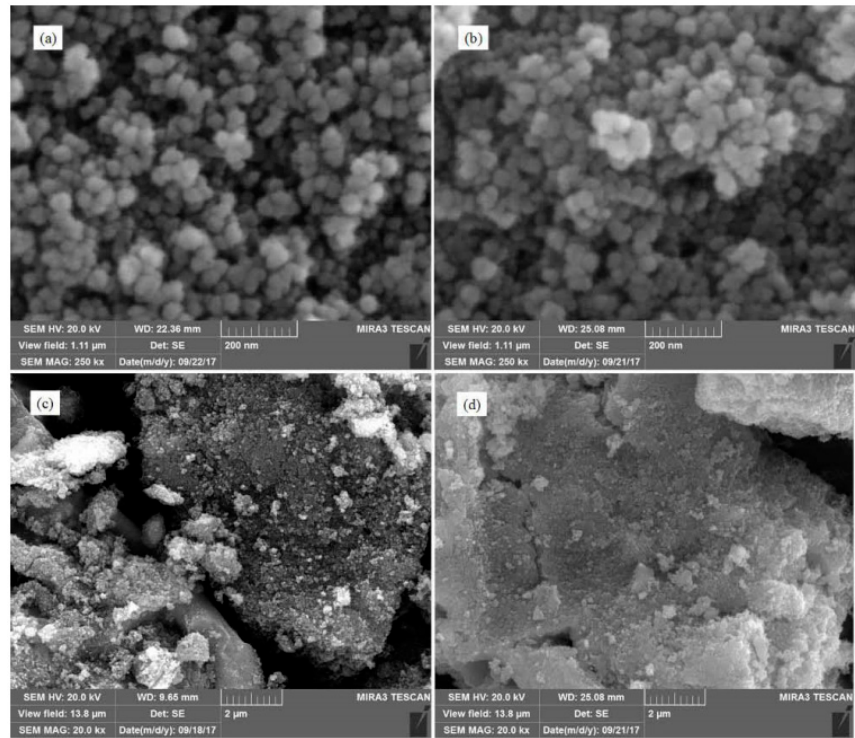
Figure 19. SEM images of two catalysts ( a ) Mn 0.4 Ce 0.07 Ho 0.1 /TiO 2 , ( b ) Mn 0.4 Ce 0.07 /TiO 2 , ( c ) Mn 0.4 Ce 0.07 Ho 0.1 /TiO 2 and ( d ) Mn 0.4 Ce 0.07 /TiO 2 [108].